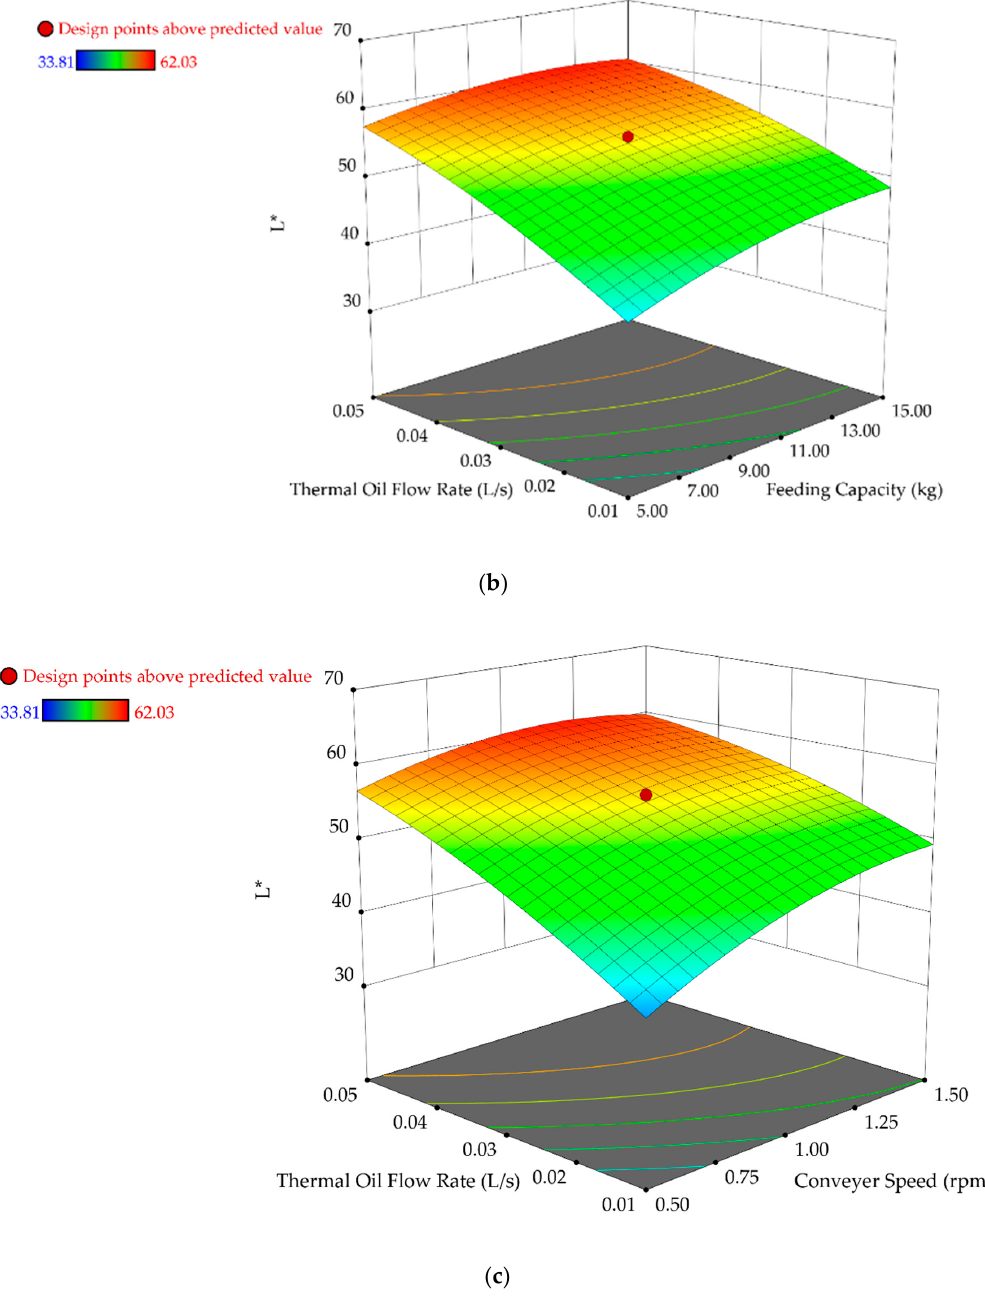
Figure 4. ( a ) Interactive effect of conveyor speed and feeding capacity on L. ( b ) Interactive effect of thermal oil flow rate and feeding capacity on L*. ( c ) Interactive effect of thermal oil flow rate and conveyor speed on L*.